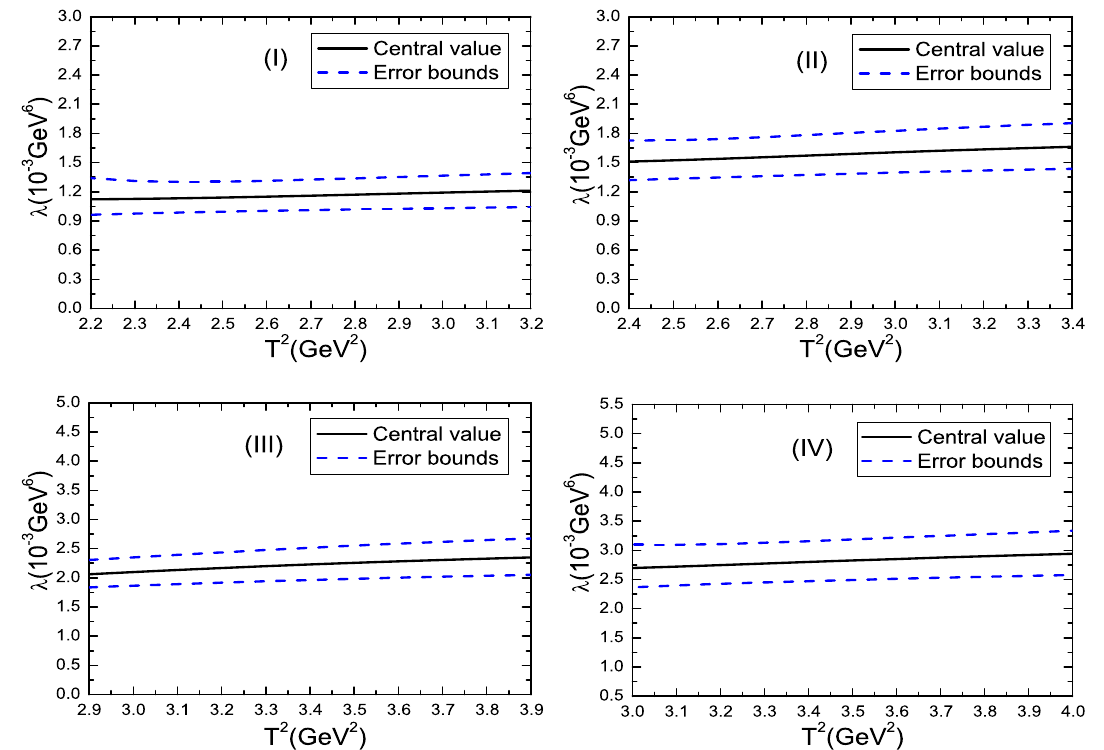
Fig. 7 The pole residues of the charmed pentaquark states with variations of the Borel parameters T 2 for the parameters C , where the (I), (II), (III) and (IV) correspond to the quantum numbers ( uuuc ¯ u , 3